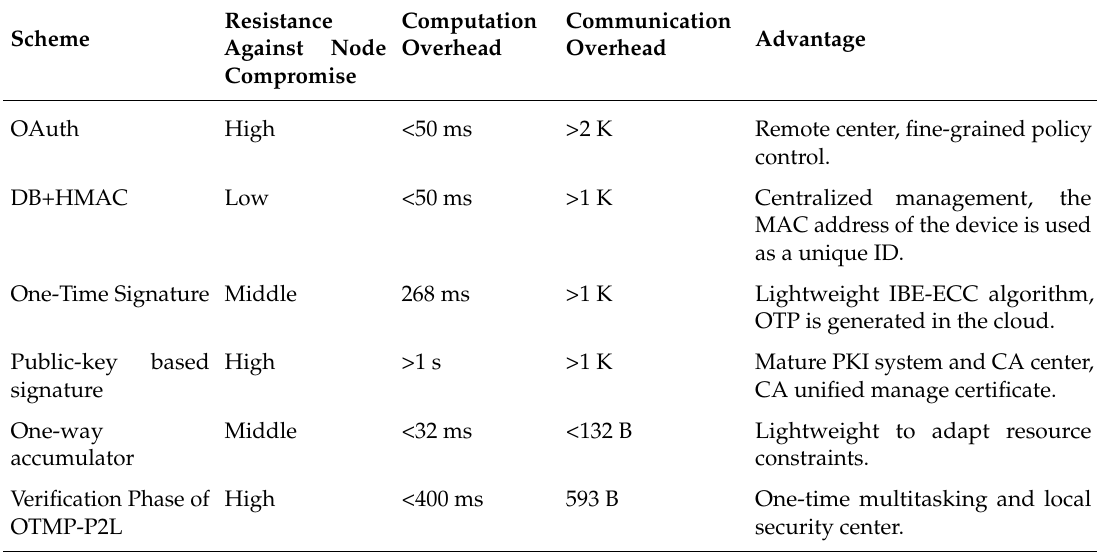
Table 4. System diagram of one-time multitask proofs scheme for peer to local (P2L)